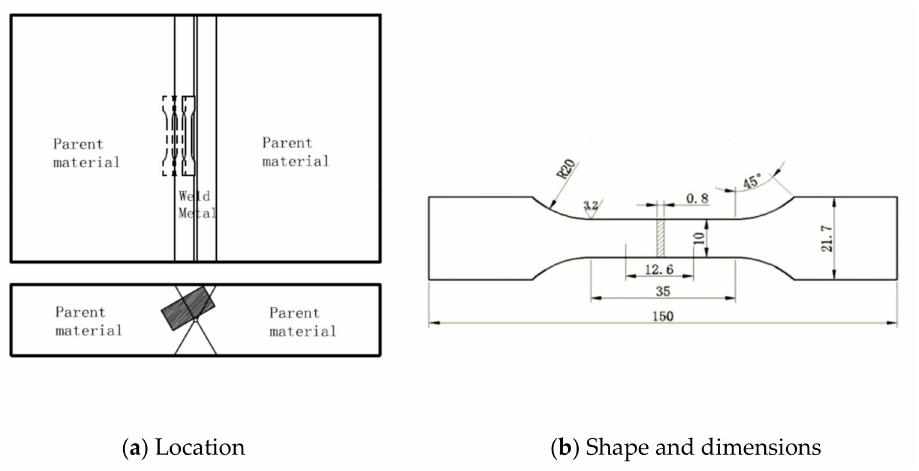
Figure 11. The location and size of the flat tensile specimen. ( a ) Location; ( b ) Shape and dimensions.